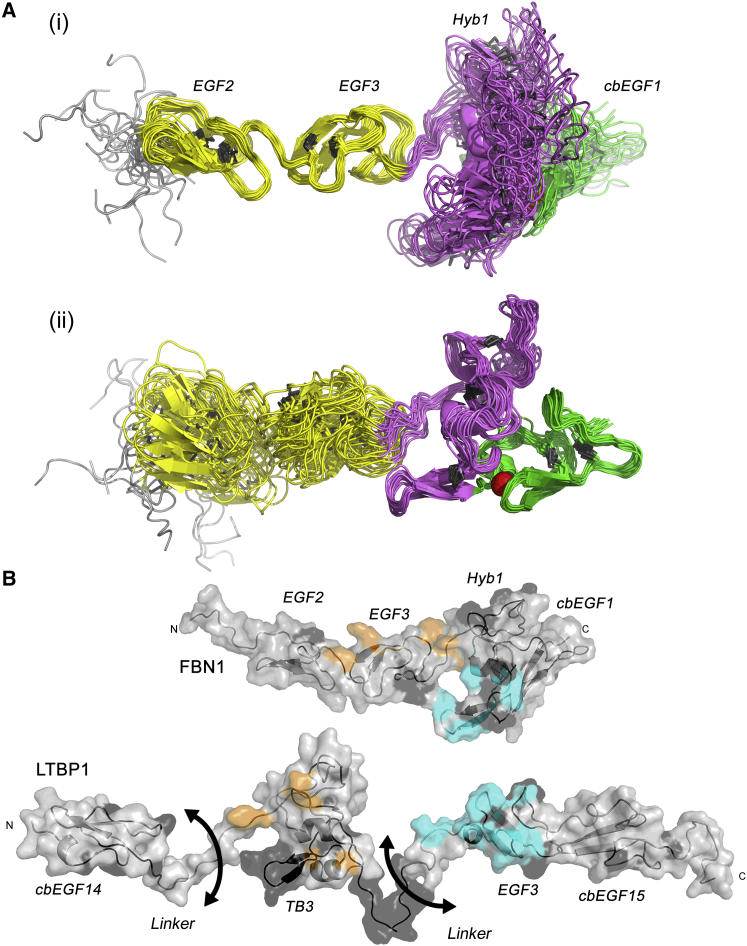
Solution Structural Ensemble of FBN1E2cbEGF1 and Interaction Sites Mapped onto the FBN1 and LTBP1 Structures(A) Cartoon representation of the 20-structure ensemble of FBN1E2cbEGF1 with structures aligned to (i) the EGF2-EGF3 domain pair or (ii) the Hyb1-cbEGF1 domain pair. The EGF, Hyb, and cbEGF domains are colored in yellow, purple, and green, respectively, the calcium ion is shown as a red sphere, and disulfide bonds are shown as dark gray lines.(B) Residues identified by peak shifts or peak broadening in HSQC spectra from FBN1 and LTBP1 titrations are highlighted on the solution structure of the EGF2-EGF3-Hyb1-cbEGF1 region of FBN1 and on a validated homology model of the cbEGF14-TB3-EGF3-cbEGF15 region of LTBP1 (Robertson et al., 2011, Robertson et al., 2014). Residues in FBN1 and LTBP1 that experience combined peak shifts of more than 0.06 and 0.05 ppm, respectively, in titrations of FBN1E2cbEGF1 with LTBP1cb14TB3 are shown in orange. Residues in FBN1 and LTBP1 that experience at least a 7- or 10-fold loss of intensity, respectively, in titrations of FBN1E2cbEGF1 with LTBP1E3cbEGF15 are shown in cyan. In both proteins, residues that have shifts or intensity changes below the relevant thresholds are shown in light gray, whereas residues that were not assigned are shown in dark gray. See also Figures S3 and S4.